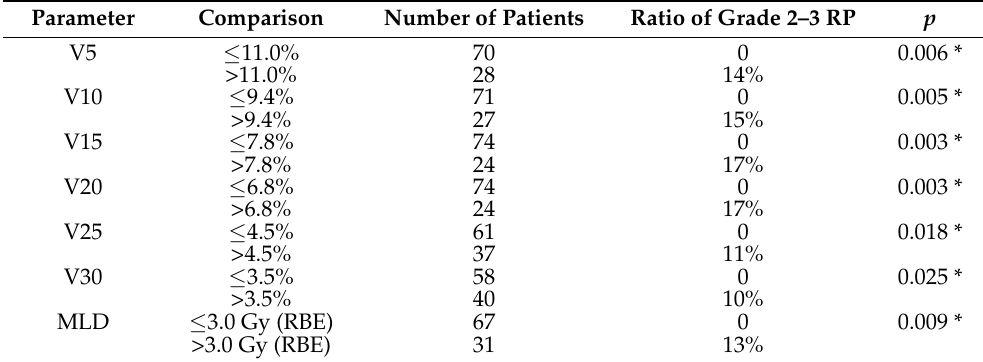
Table 3. The comparison before and after cut-off values calculated by using receiver operating characteristic